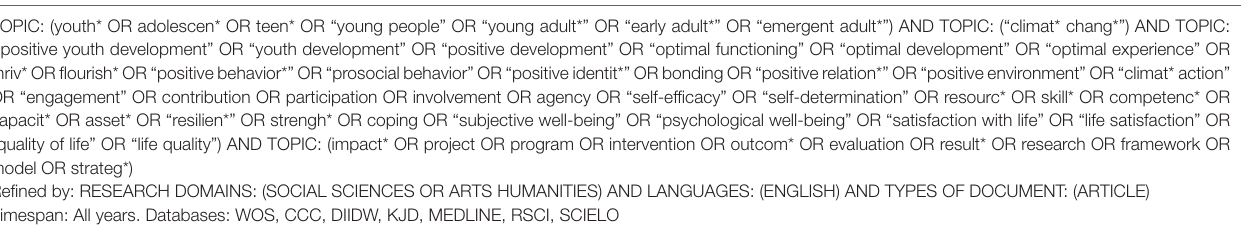
TABLE 1 | Search strings on Web of